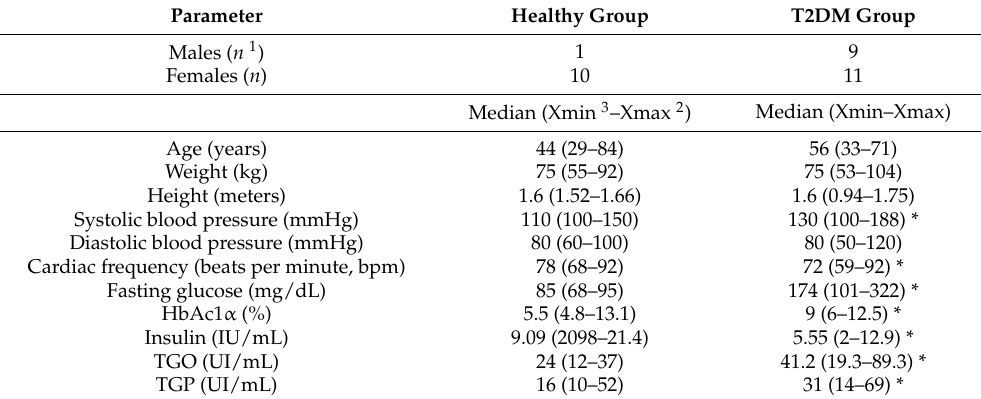
Table 1. Clinical and anthropometric data of the study population representing the median (Xmin–Xmax). Parameter Healthy Group